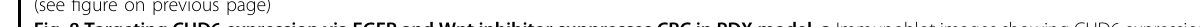
Fig. 8 Targeting CHD6 expression via EGFR and Wnt inhibitor suppresses CRC in PDX model. a Immunoblot images showing CHD6 expression in four cases of PDX tumors. b Schematic diagram of the cetuximab treatment after the establishment of PDX tumors in immunocompromised mice. c Growth of the indicated PDX tumors that were treated with either Cetuximab or PBS as control. n = 4 biological replicates. Data are presented as means ± SD. *** P < 0.001, ns, not signi fi cant. P values were calculated by two-way ANOVA. d Representative images of IHC staining for Ki67 in PDX tumor sections with the indicated treatments (left) and quanti fi cation of Ki67-positive areas (right). n = 4, data are presented as means ± SD. ** P < 0.01, ns, not signi fi cant. P values were calculated by two-tailed t -test. e Immunoblot images showing the indicated protein levels analyzed from the PDX tumors that were treated with either Cetuximab or PBS. f Schematic diagram of the Cetuximab and LGK974 combination treatment after the establishment of PDX tumors in immunocompromised mice. g Representative images (left) of the PDX tumors that were harvested at the end of the experiment. Growth curves showing the proliferation of PDX tumors in each indicated treatment group (right). n = 4 biological replicates. Data are presented as means ± SD. *** P < 0.001. P values were calculated by two-way ANOVA. h Representative images (left) and quanti fi cations (right) of IHC staining for CHD6, TMEM65, cleaved caspase-3, and Ki67 in PDX tumors from the indicated treatment groups. Data are presented as means ± SD. *** P < 0.001, ** P < 0.01, * P < 0.05. P values were calculated by one-way ANOVA.